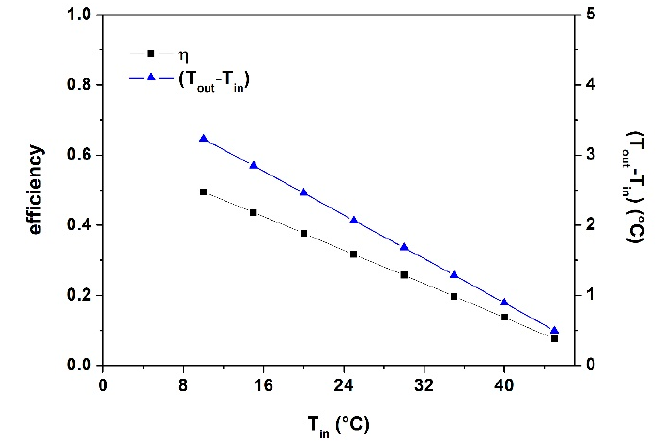
Figure 9. Results of the parametric study. Efficiency and temperature difference vs. fluid inlet temperature.